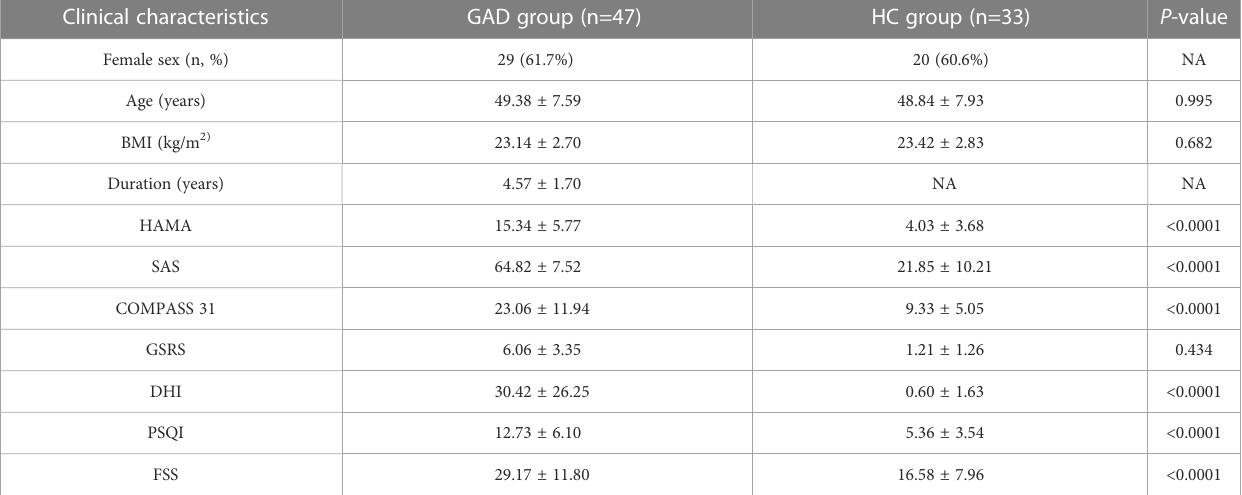
TABLE 1 Clinical characteristics of the enrolled participants. Clinical